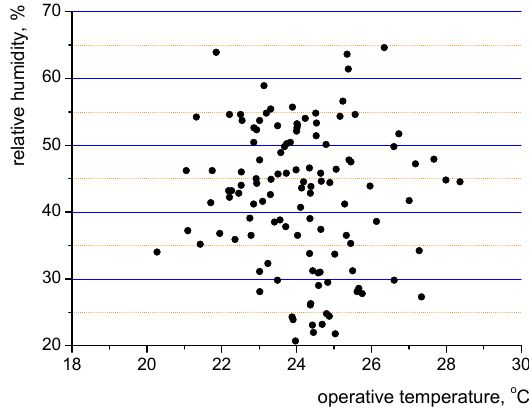
Figure 6. Operative temperature and relative humidity values in selected rooms between February 2017 and July 2018.